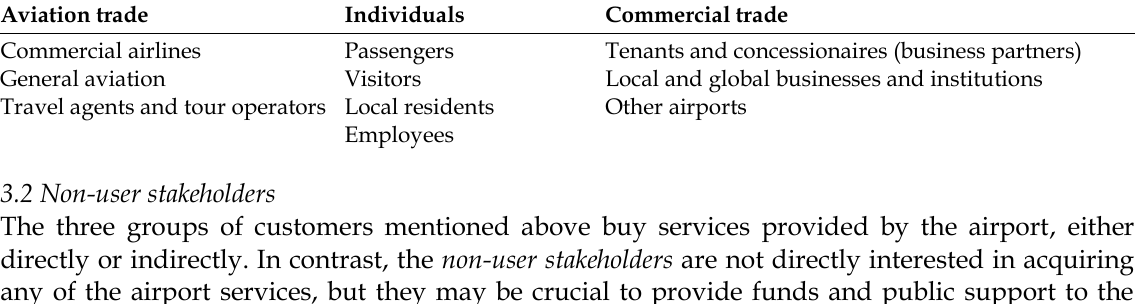
Table 1 - Customer groups for the airport